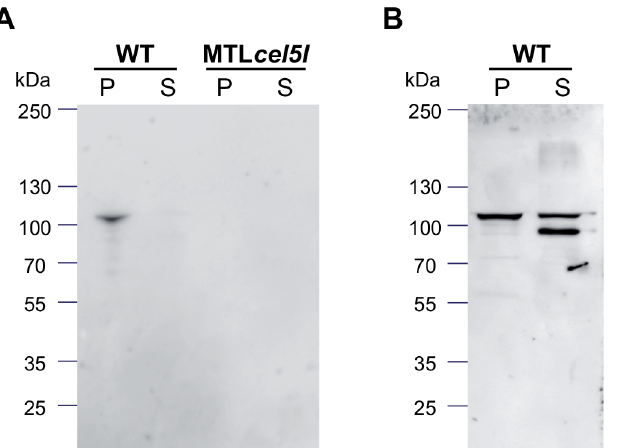
Fig 5. Detection of Cel5I in R . cellulolyticum strains. Wild-type and MTL cel5I strain were probed with anti- CBM28 antibody. Aliquot was taken from a culture on cellobiose substrate at the mid (A) or late (B) exponential phase of growth, and centrifuged to separate the cells and the supernatant. Cell fraction and 12% TCA precipitated supernatant fraction corresponding to the same culture volume were subjected to SDS-PAGE. After transfer onto nitrocellulose membranes, membranes were probed with the antiserum raised against CBM28.